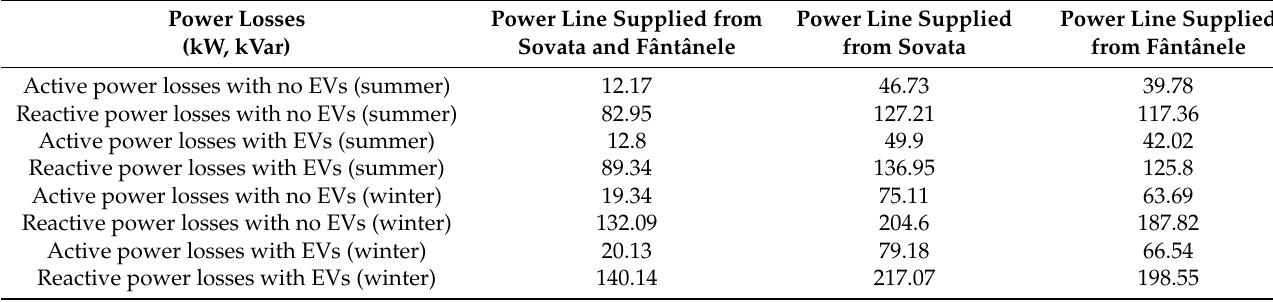
Table 33. Power losses at 23:00 (scenario 7).